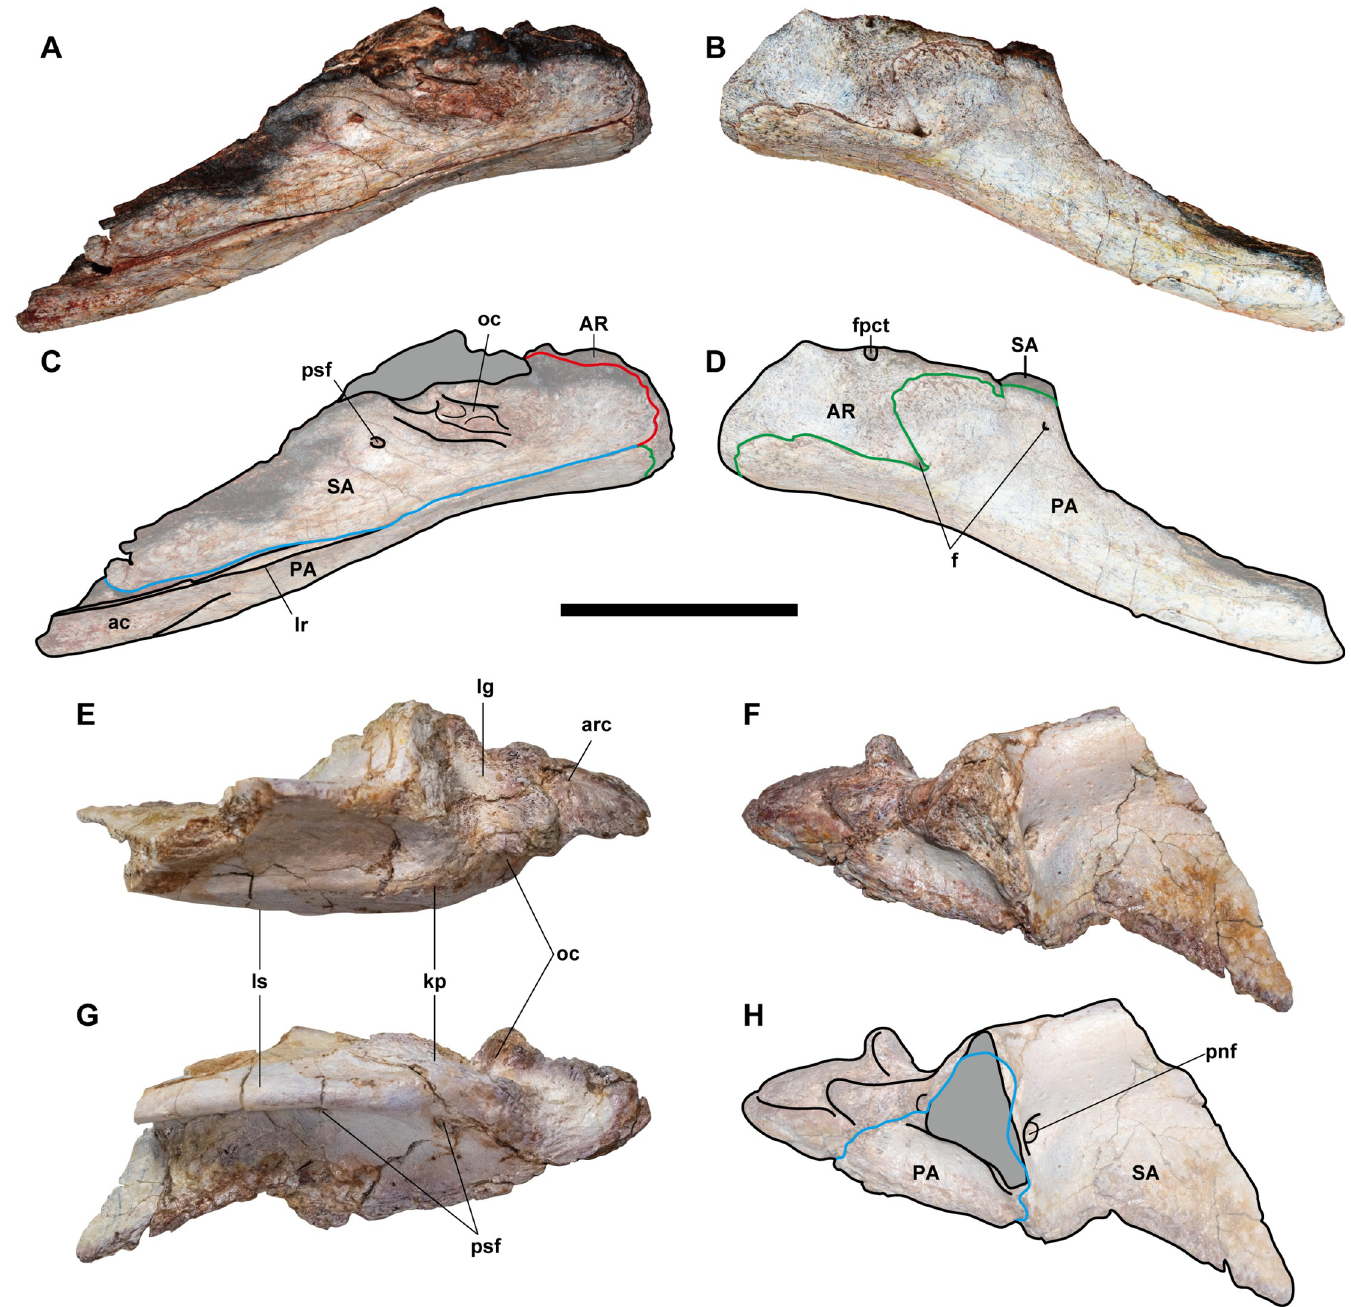
Fig 8. Posterior parts of the left mandibles, NRRU-F01020007 (A–D) and F01020010 (E–H) in lateral (A, C, G), medial (B, D, F, G), and dorsal (E) views. Red, blue, and green lines indicate the surangular (SA)/articular (AR), surangular/prearticular (PA), and articular/prearticular sutures, respectively. Abbreviations: ac, angular contact; arc, articular contact; AR, articular; f, foramen; fpct, foramen posterior chorda tympani; kp, knob-like process; lg, lateral glenoid; lr, longitudinal ridge; ls, lateral shelft; oc, oval concavity; PA, prearticular; pnf, pneumatic foramen; psf, posterior surangular foramen; SA, surangular. Scale bar equals 100 mm for A-D and 60 mm for